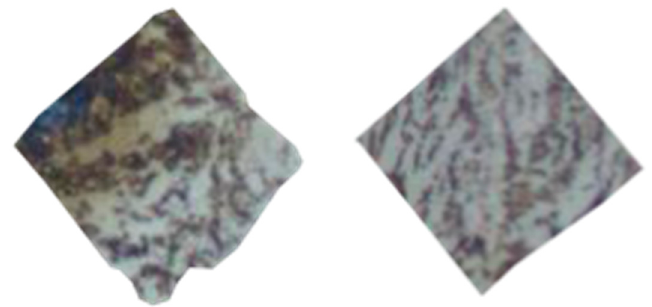
Figure 2. Example results obtained by the Vickers hardness assessment method for SCM 440.